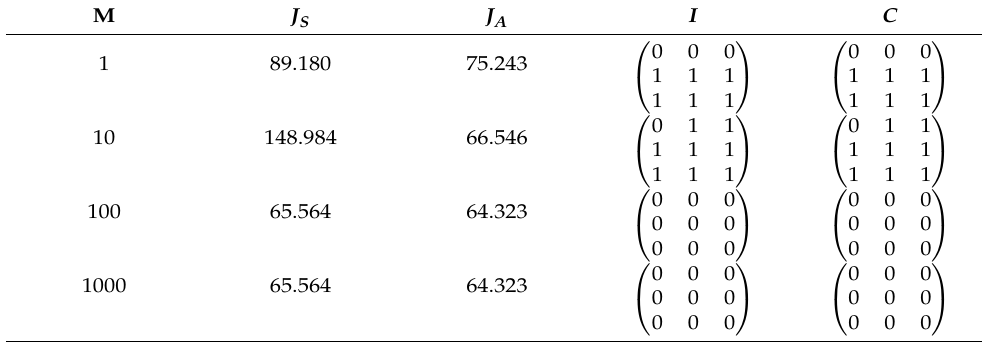
Table 2. Players’ optimal strategies and payoffs in dependence of the penalty value M.